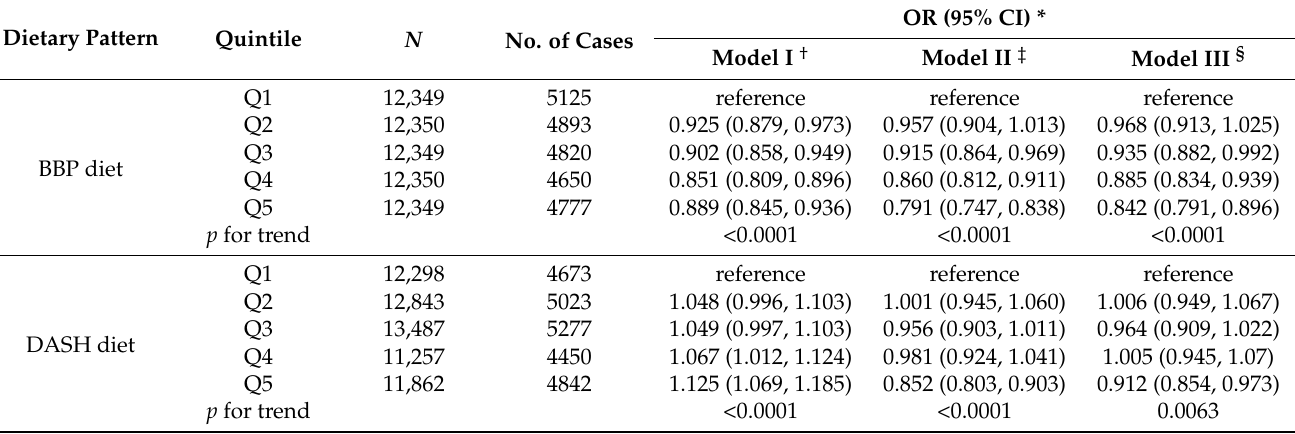
Table 2. Association between dietary pattern scores and risk of hypertension in the